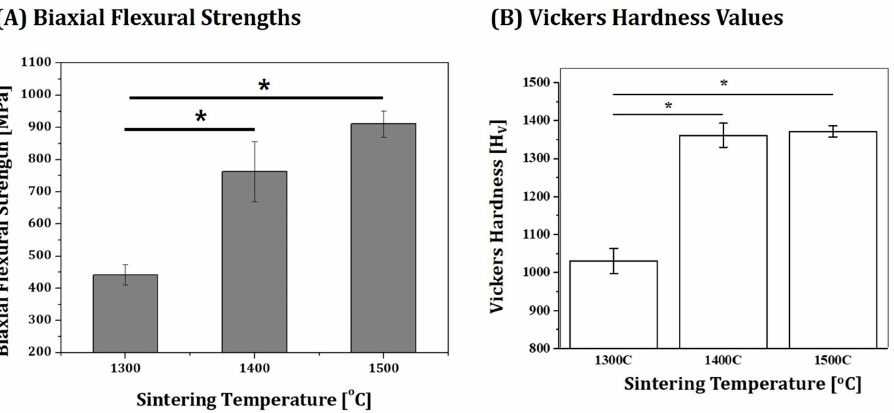
Figure 13. ( A ) Measured biaxial flexural strengths (* p < 0.05) and ( B ) Vickers hardness values of 4Y-PSZ disks sintered at various temperatures (1300 °C, 1400 °C, and 1500 °C) (* p < 0.05).